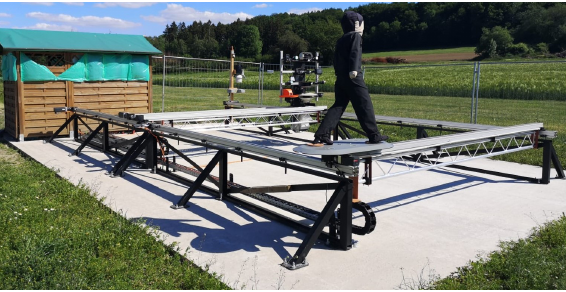
Figure 1. The first outdoor sensor test stand in agriculture is presented. The test stand can create REDAs and is working 24 h a day 365 days a year. Reprinted from Ref.